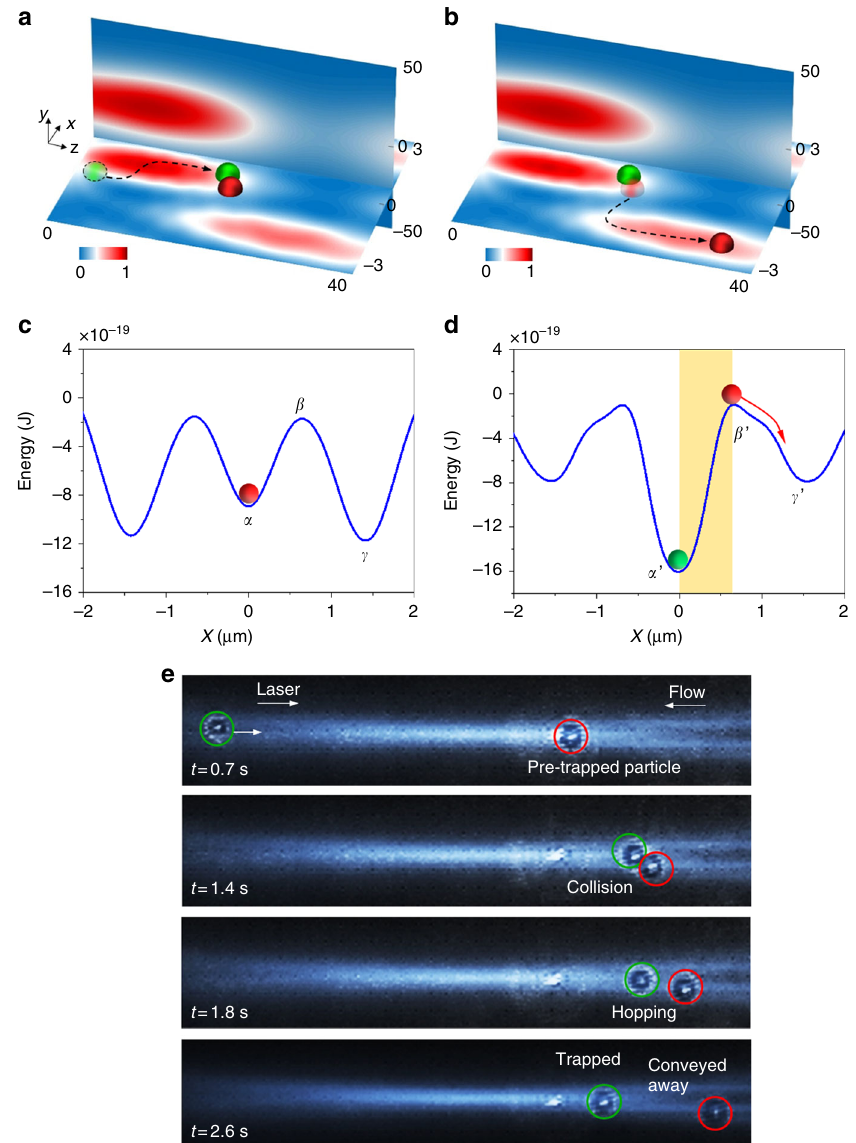
Fig. 3 Snookering-like particle collision-induced hopping between potential wells. Illustration of the particle a collision and b hopping combining with optical intensity pro fi les of the lattice. The energy pro fi le of the potential wells c before and d after the particle collision, plotted along x -axis at y = 0 and z = 20 μ m. e Experimental demonstration of the particle collision-induced hopping between potential